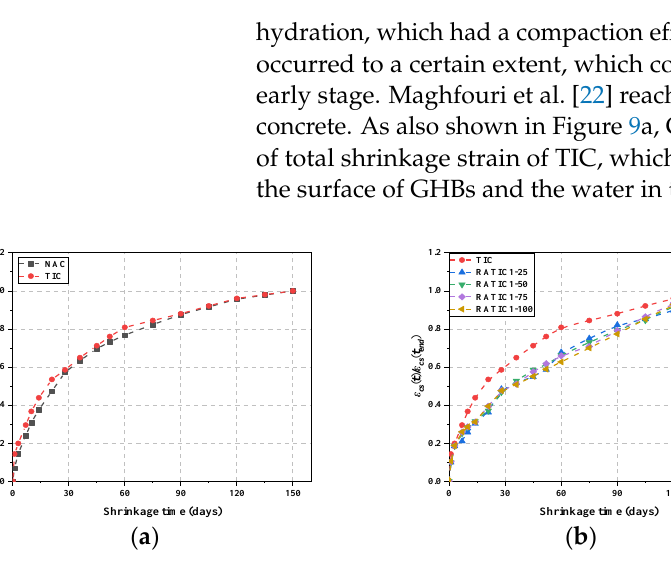
Figure 9. Normalized total shrinkage of ( a ) NAC and TIC, ( b ) RATIC1 and ( c )